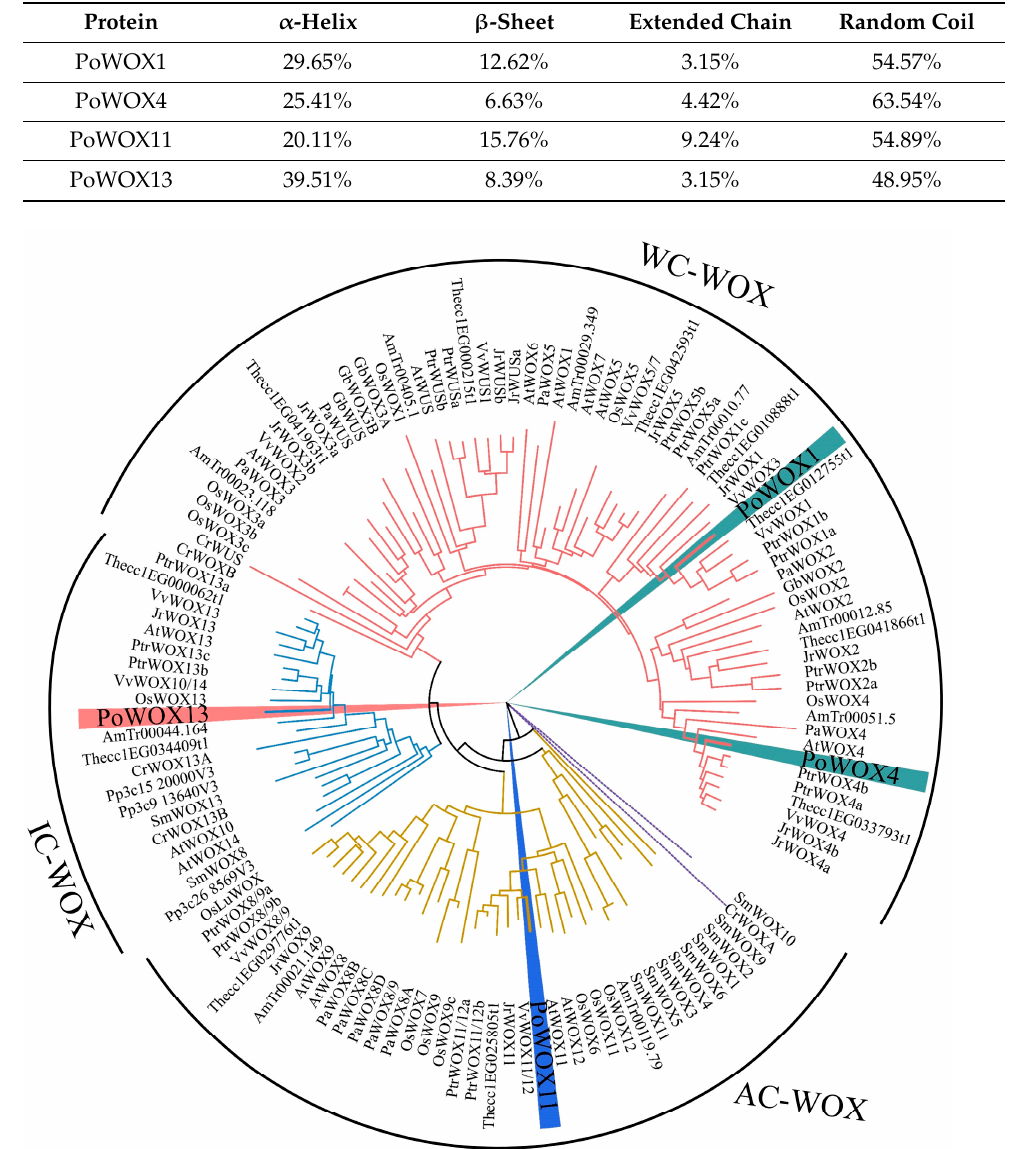
Table 7. Predicted secondary structure of PoWOX proteins.